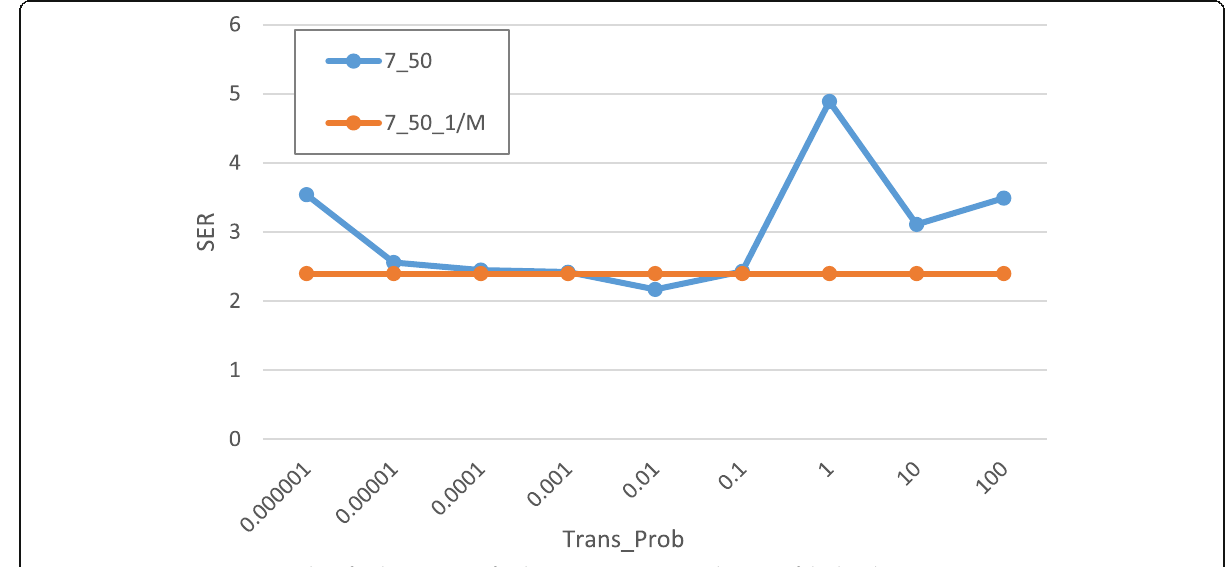
Fig. 17 SER across transition weight K for the DEVELSET for the point 7-50 compared to SER of the baseline (1/M)